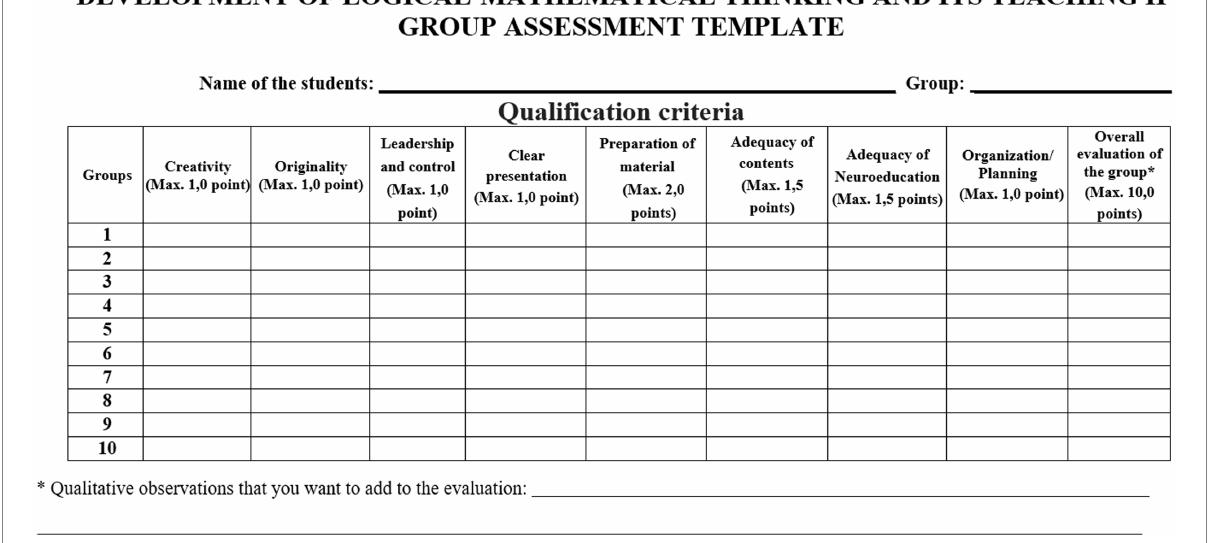
FIGURE 1 Group evaluation rubric.